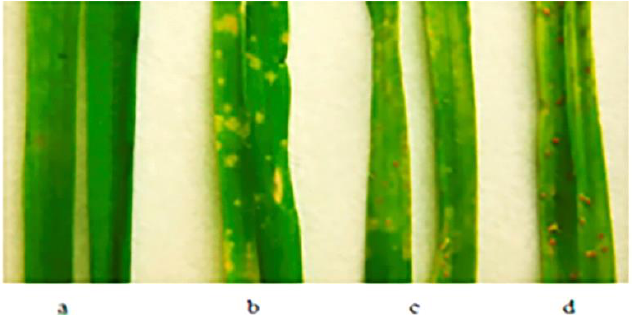
Figure 1. Seedlings of wild wheat species samples from the VIR collection after infection with population of P. triticina : ( a ) T. boeoticum k-66369; ( b ) T. urartu k-64777; ( c ) T. araraticum k-66372; and ( d ) T. boeoticum k-59178 (susceptible). Samples of T. urartu k-33870, k-33871, T. boeoticum k-27141, k-28283, k-58611, k-59159, Table 3. Samples of wild wheat species from the VIR collection that are highly resistant to leaf rust. k-59163, k-59178, T. dicoccoides k-15907, k-20403, and T. araraticum k-30258, k-30240, k-